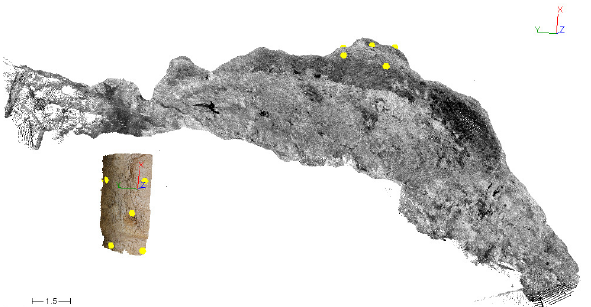
Figure 4. Input datasets: in grayscale, registered laser scanning point cloud data; in colour, photogrammetric point cloud.